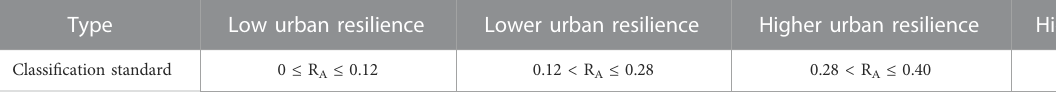
TABLE 6 Classi fi cation criteria for urban resilience levels in the study area.